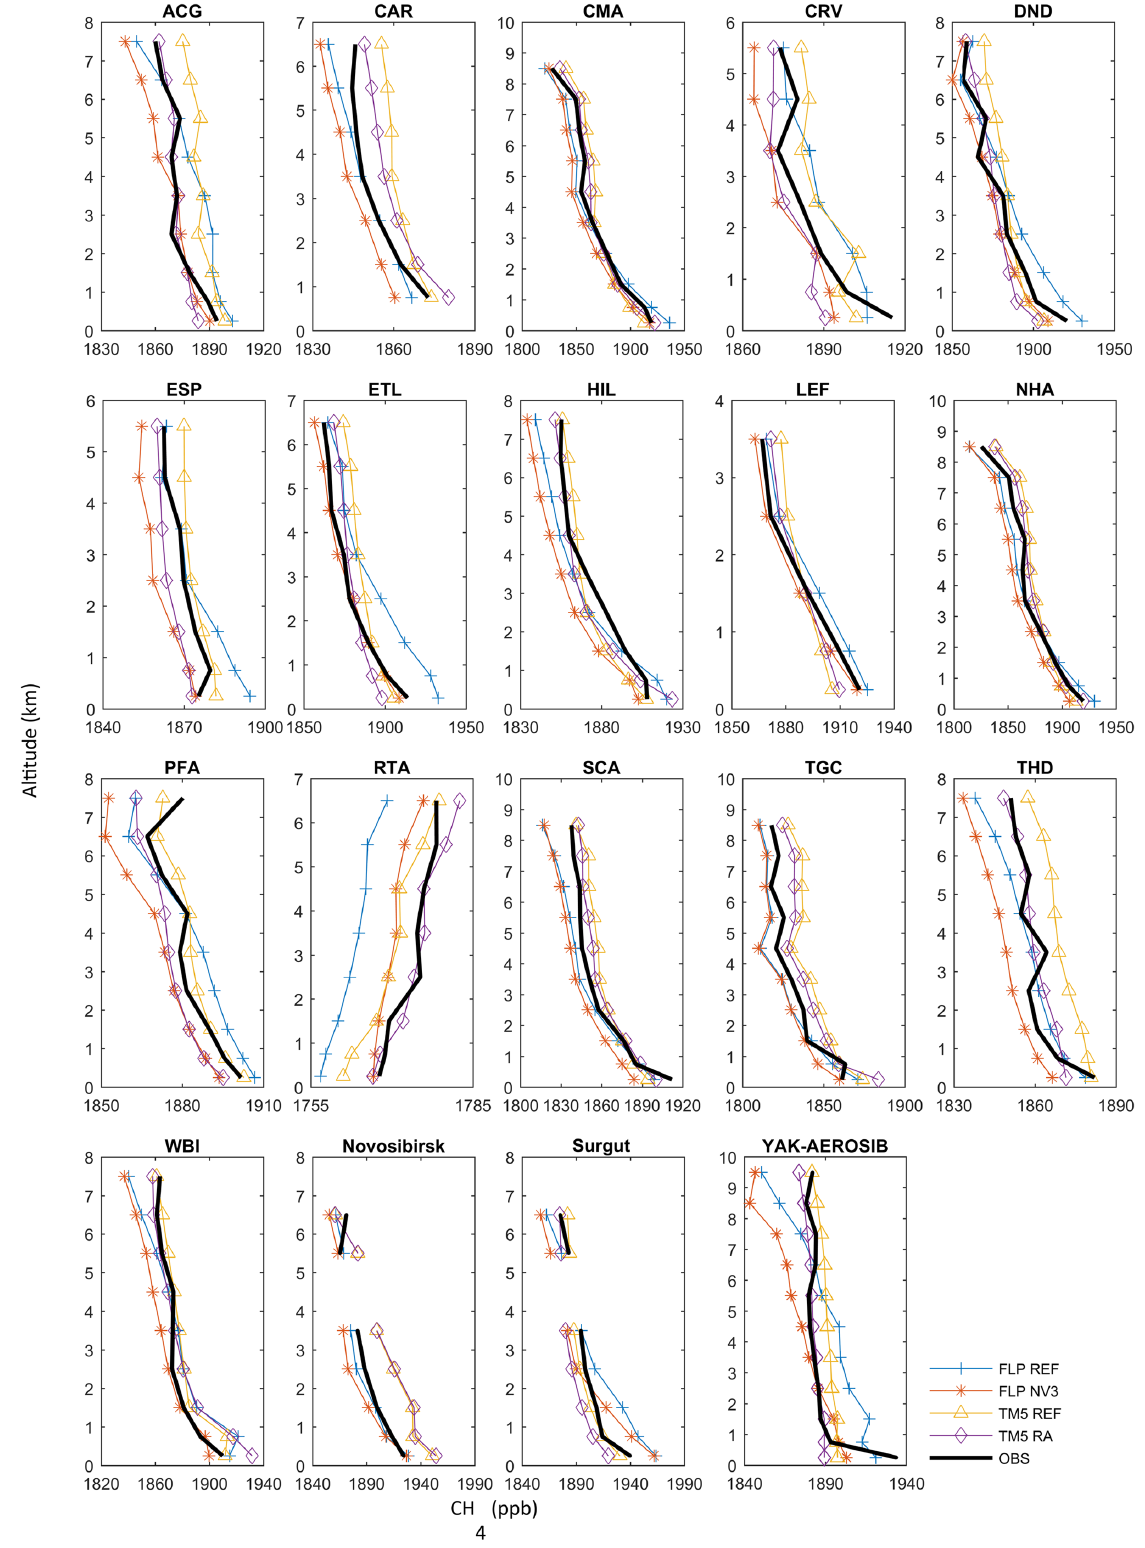
Figure 11. Averaged modelled and observed vertical profiles in 2013 at 16 NOAA locations, during the YAK-AEROSIB campaign and in Surgut and Novosibirsk. FLP refers to FLEXPART